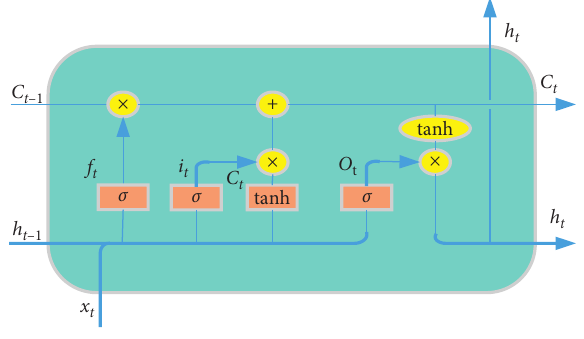
Figure 6: LSTM prediction